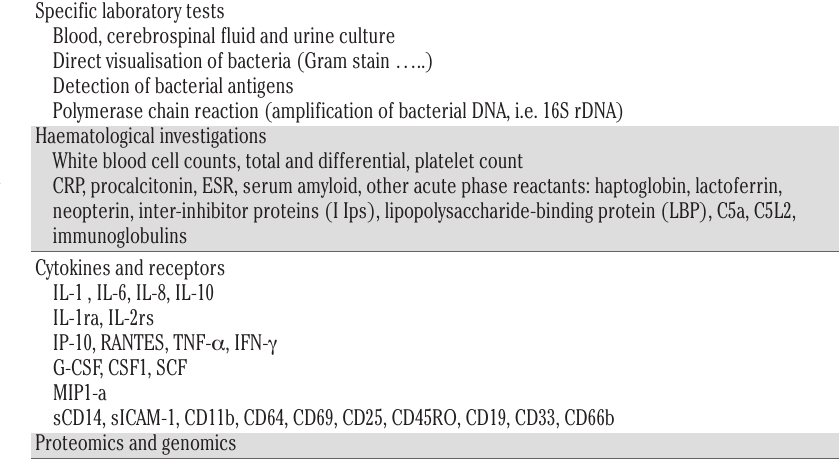
Table 1. Laboratory investigations for diagnosis of neonatal sepsis Specific laboratory tests Blood, cerebrospinal fluid and urine culture Direct visualisation of bacteria (Gram stain …..) Detection of bacterial antigens Polymerase chain reaction (amplification of bacterial DNA, i.e. 16S